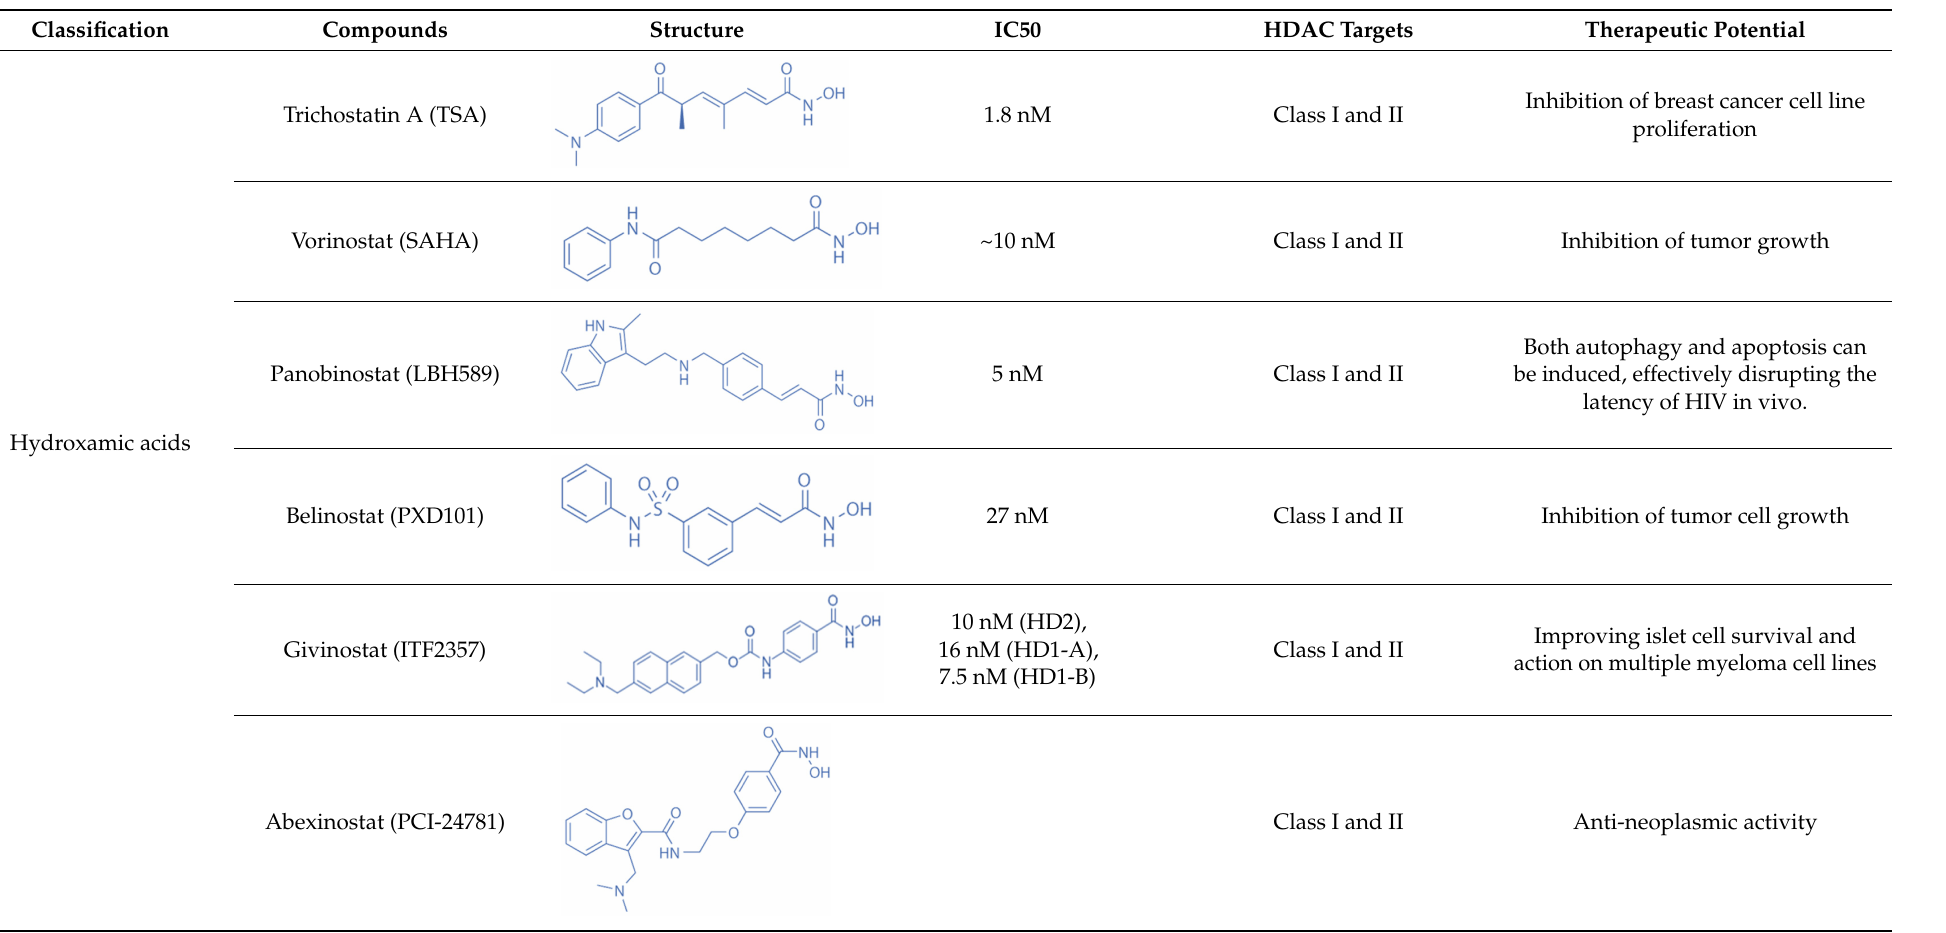
Table 2. Classification of